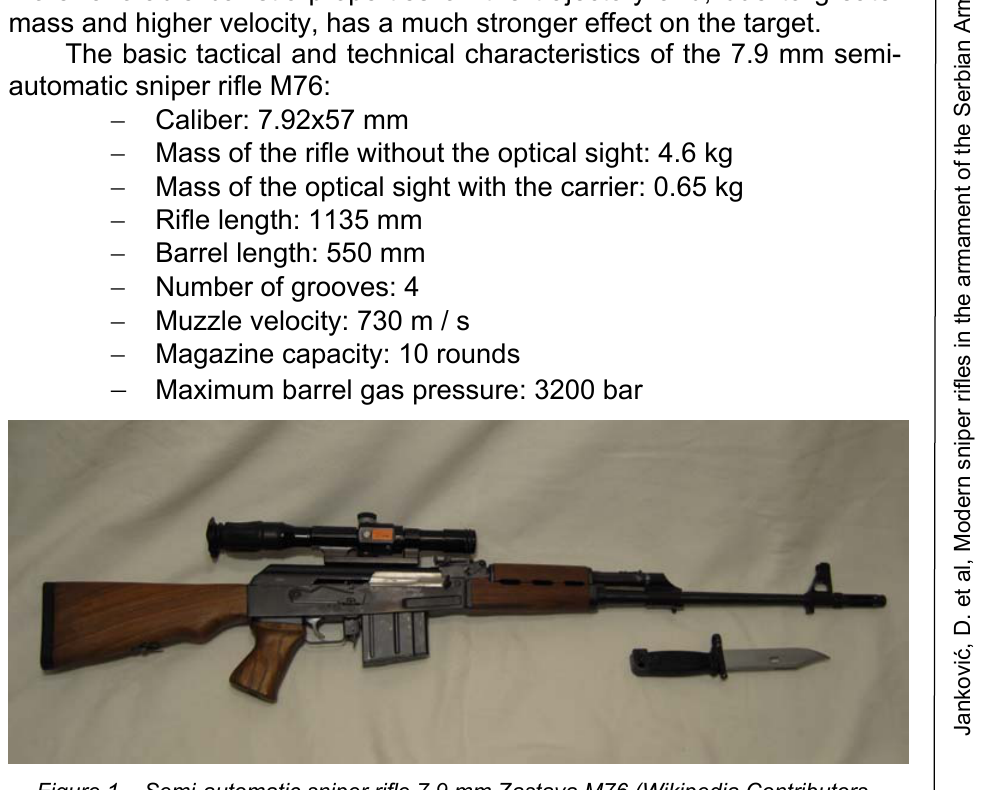
Figure 1 – Semi-automatic sniper rifle 7.9 mm Zastava M76 (Wikipedia